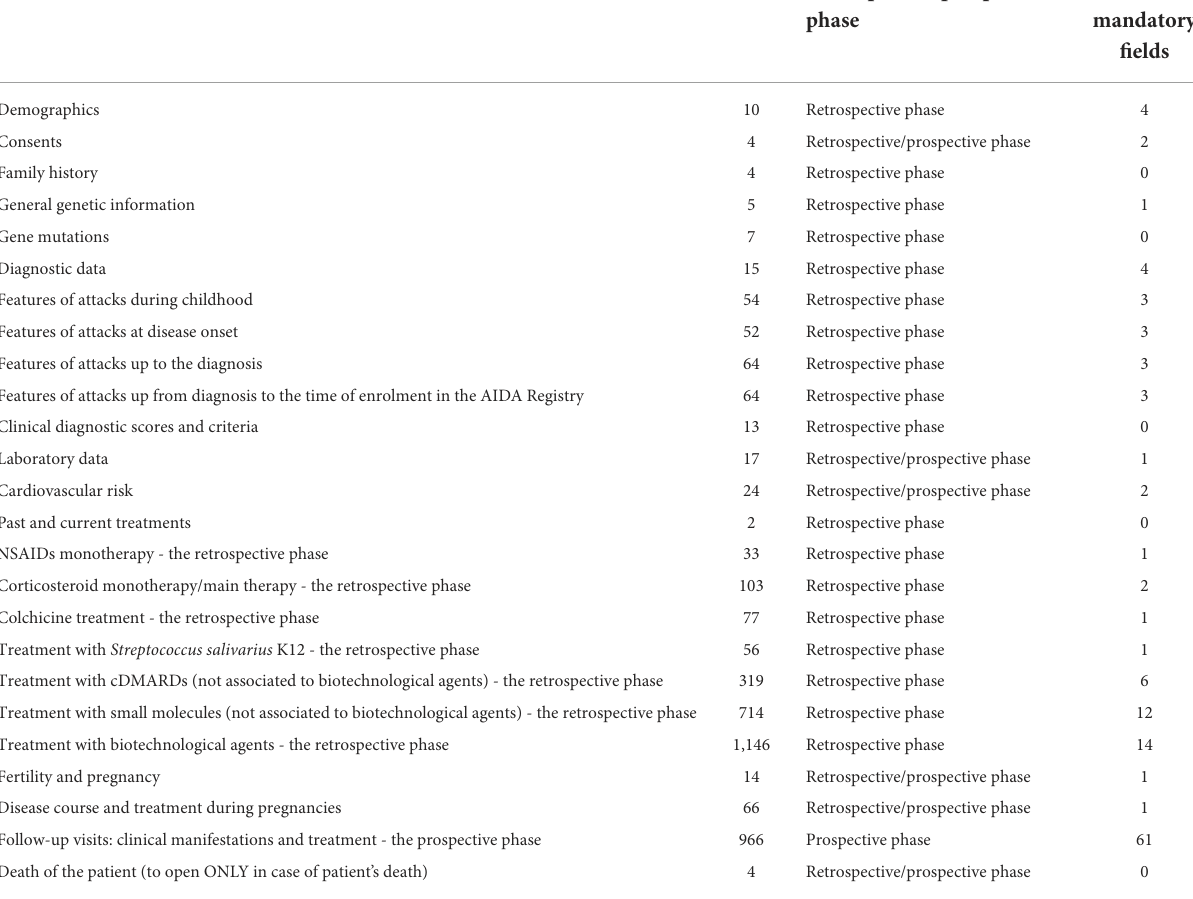
TABLE 2 List of instruments (to be meant as “forms”) included in the Registry dedicated to patients with PFAPA syndrome, with the corresponding number of common data elements, time-points at which they should refer to (retrospective/prospective phase) and number of mandatory fields